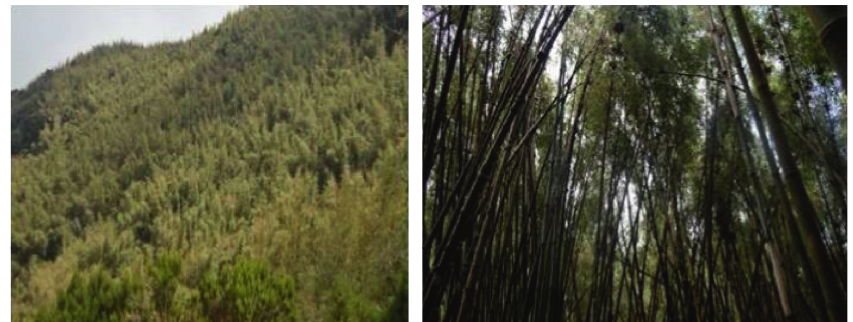
Figure 3: Alpine bamboo forest habitat at Geremba Mountain (photo: Zerubabel Worku, 2018).